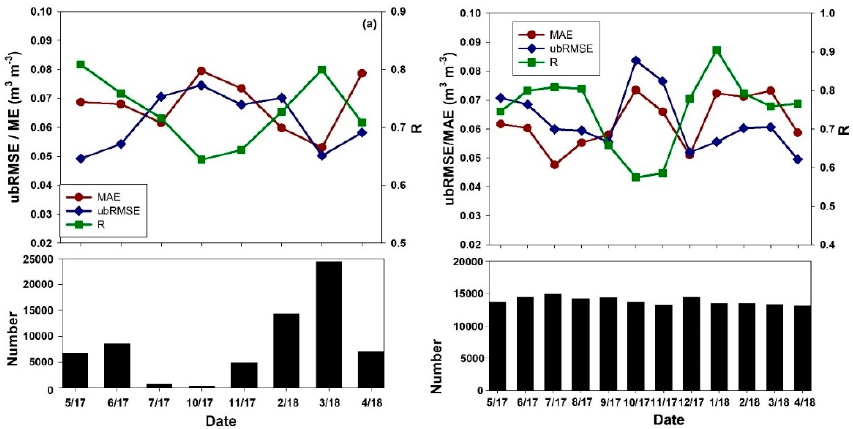
Figure 9. Comparisons of the three statistical indices (i.e., ubRMSE, MAE, and R) between TDS-1/ CYGNSS and SMAP. ( a ) TDS-1 vs. SMAP, ( b ) CYGNSS vs.